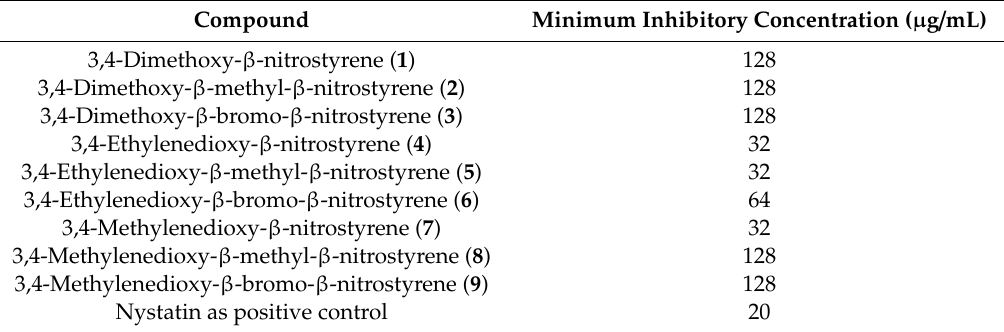
Table 2. Antimicrobial activity of the 3,4-dimethoxy- β -nitrostyrene derivatives against Candida albicans